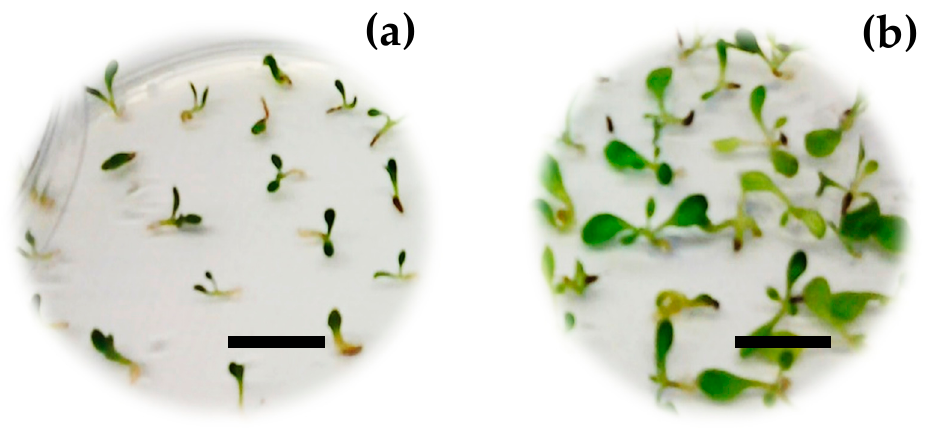
Figure 2. Germination of Taraxacum officinale in SUC at ( a ) 5.5% and ( b ) 2.3%. (0.5 mg/L NAA, 0.5 mg L/L BAP, 18/6 h light/dark, 18 ±2.0 °C, two weeks after germination). The size of the bars is 1 cm.